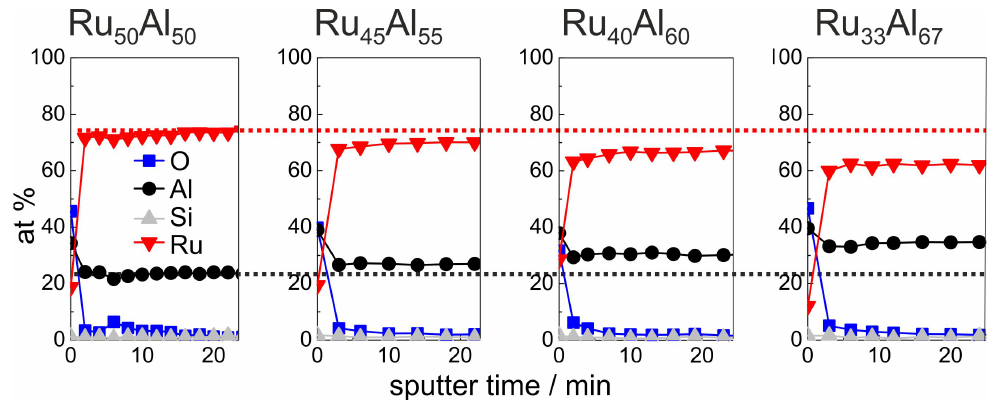
Figure 4. AES measurements of the as deposited samples with the different compositions Ru 50 Al 50 , Ru 45 Al 55 , Ru 40 Al 60 and Ru 33 Al 67 . The red (black) dotted line marks the Ru (Al) content in the reference Ru 50 Al 50 sample to visualize the difference to the other